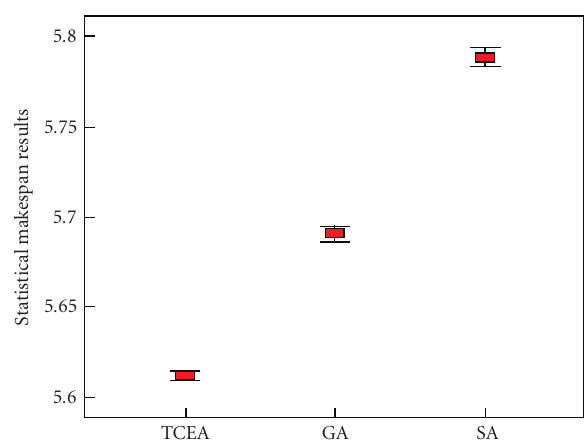
Figure 10: Statistical results of 3-level MLPS with TCEA, GA, and SA.